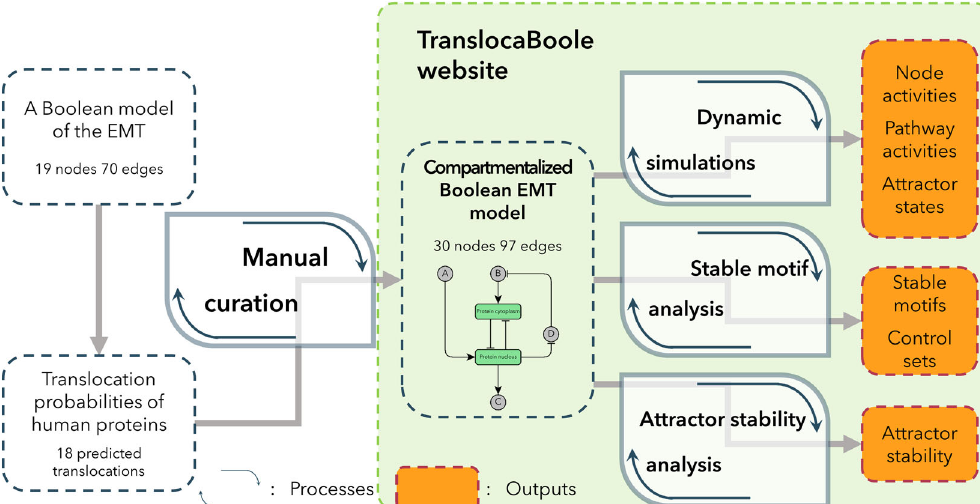
Fig. 3 Work fl ow for the creation and evaluation of a compartmentalized Boolean model. Starting from previously published Boolean models of the EMT with the help of the Translocatome database 5 it is possible to uncover translocating nodes that need to be compartmentalized. The careful revision of available literature i.e., manual curation, through the creation of new Boolean functions (based on the collected experimental data) enables the creation of a compartmentalized model. This is followed by dynamic simulation which could be analysed as different outputs on different levels, such as node or pathway activities or the identi fi cation of stable attractors of a system. Other analyses can identify the stable motifs and control sets of a model or calculate attractor stability measures. The website (https:// translocaboole.linkgroup.hu/) enables users to modify our model and to automatically run simulations with our standard settings (25 iterations and 20,000 steps, every node is perturbed) and download the